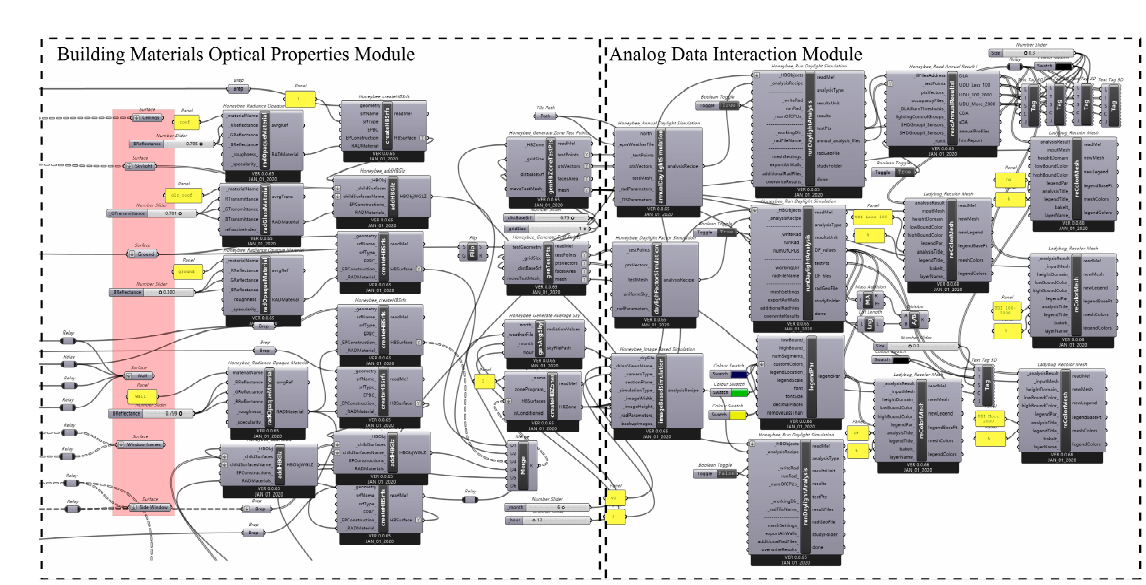
Figure 7. Flow chart of the parametric simulation program of optical environment.